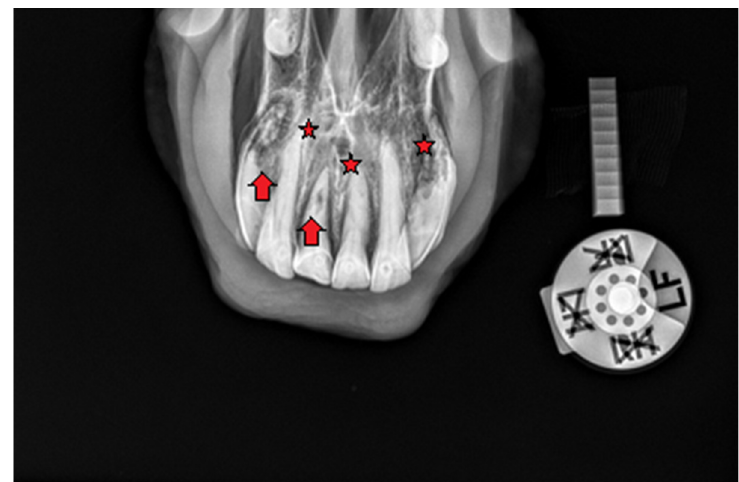
Figure 3. Case 1—intraoral radiograph of maxillary incisor teeth. Red arrows show areas of extensive resorption. Osteomyelitis of maxilla (red stars).